Question: Briefly state, in one sentence, what is plotted here.
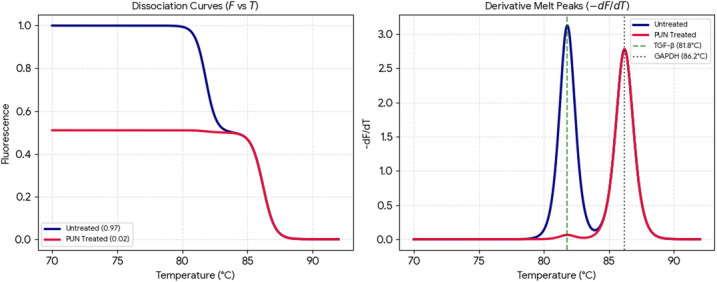
Answer: Real-time quantitative PCR melt curve and product dissociation profiles. Left Panel: Raw dissociation curve mapping tracking cellular fluorescence intensity (F) against Temperature (°C) for the Untreated (0.97 relative baseline) and PUN Treated (0.02 relative baseline) HNO-97 cell lines. Right Panel: Quantitative derivative melt peak profile (-dF/dT versus Temperature) demonstrating strict gene-specific sequence targeting. The presence of single, distinct clean amplification curves identifies the specific target melting temperature (Tm) of the TGF-β gene at 81.8 °C (green dashed line) and the internal housekeeper GAPDH reference control gene at 86.2 °C (black dotted line), confirming the complete absence of secondary non-specific amplicons or primer-dimer artifacts.